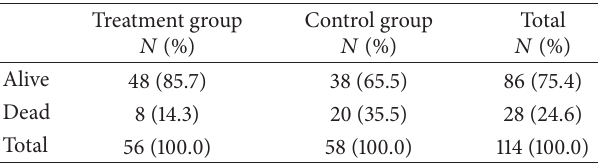
Table 4: Analysis of mortality rates between the groups with chi- square ∗ tests which shows that zoledronic acid provides significant decrease at the mortality